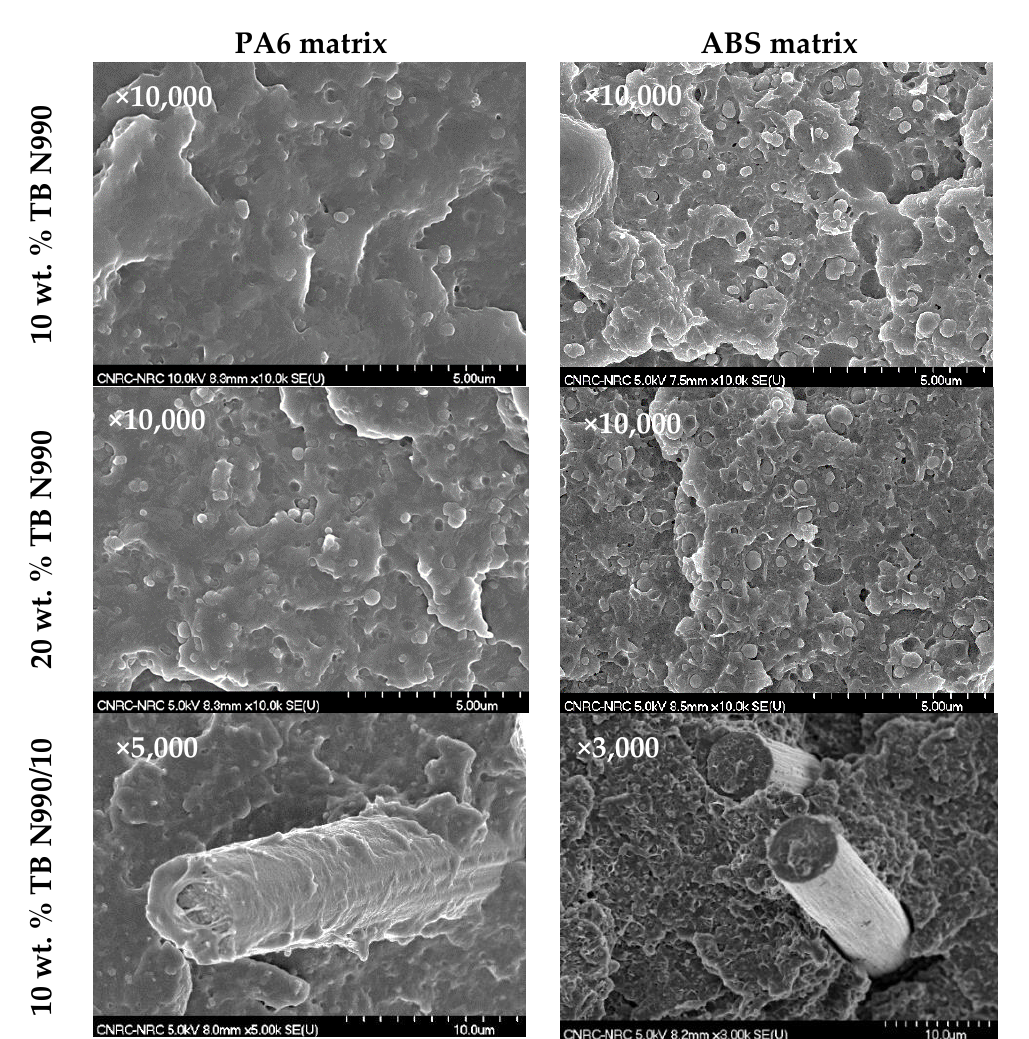
Figure 13. Micrographs of composites based on PA6 matrix (1st column), ABS matrix (2nd column), with 10 wt. % TB N990 (1st row), 20 wt. % TB N990 (2nd row), and 10 wt. % TB N990 / 10 wt. % CF (3rd row).